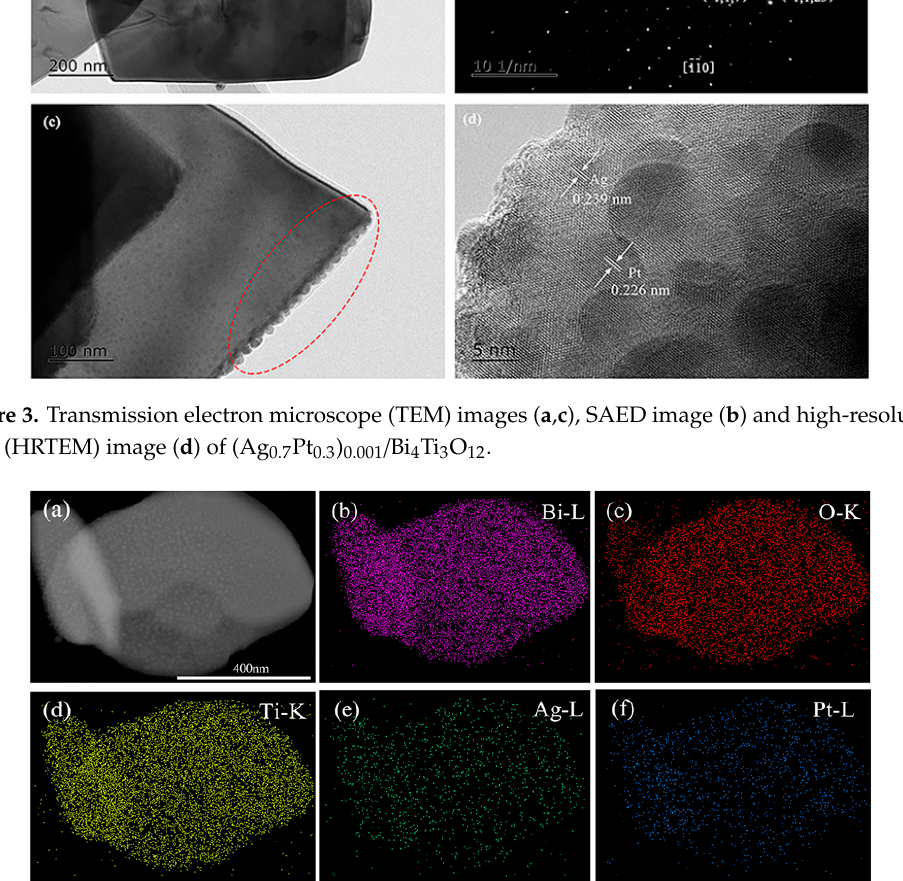
Figure 4. TEM image ( a ) and EDS maps of Bi, O, Ti, Ag and Pt ( b – f ) of as-prepared (Ag 0.7 Pt 0.3 ) 0.001 /Bi 4 Ti 3 O 12 .